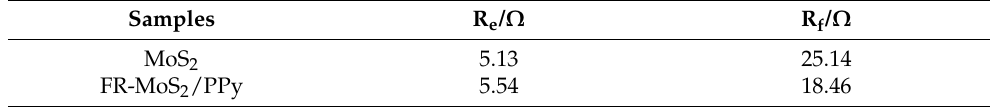
Figure 7. ( a ) EIS plots of MoS 2 and FR-MoS 2 /PPy after 20 cycles under 200 mA g − 1 , ( b ) Z ′ vs. ω − 0.5 plots calculated from EIS under low frequency. Table 1. EIS fitting results of MoS 2 and FR-MoS 2 /PPy.